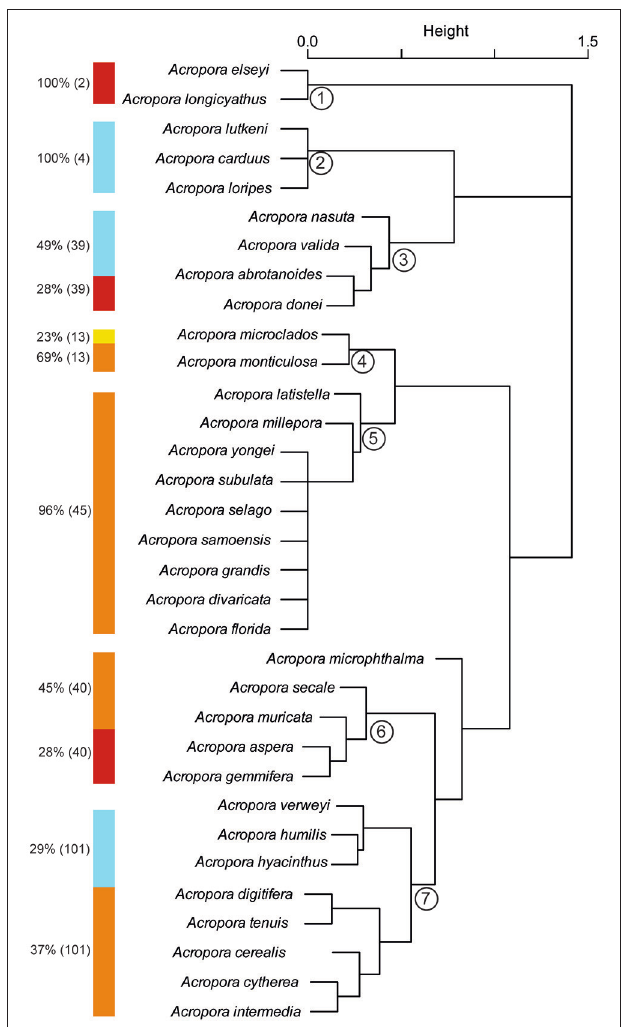
FIGURE 7 | Cluster analysis of Acropora species observed at Lizard Island based on records of occurrence of different bleaching severity in the literature. Color bars adjacent to each cluster show the bleaching severity observed in at least 20% of records for the species (dark blue, no bleaching; pale blue, low bleaching; yellow, moderate bleaching; orange, high bleaching; red, severe bleaching). Percentage values adjacent to color bars show percentage of records in each bleaching category and values in parentheses show number of records.